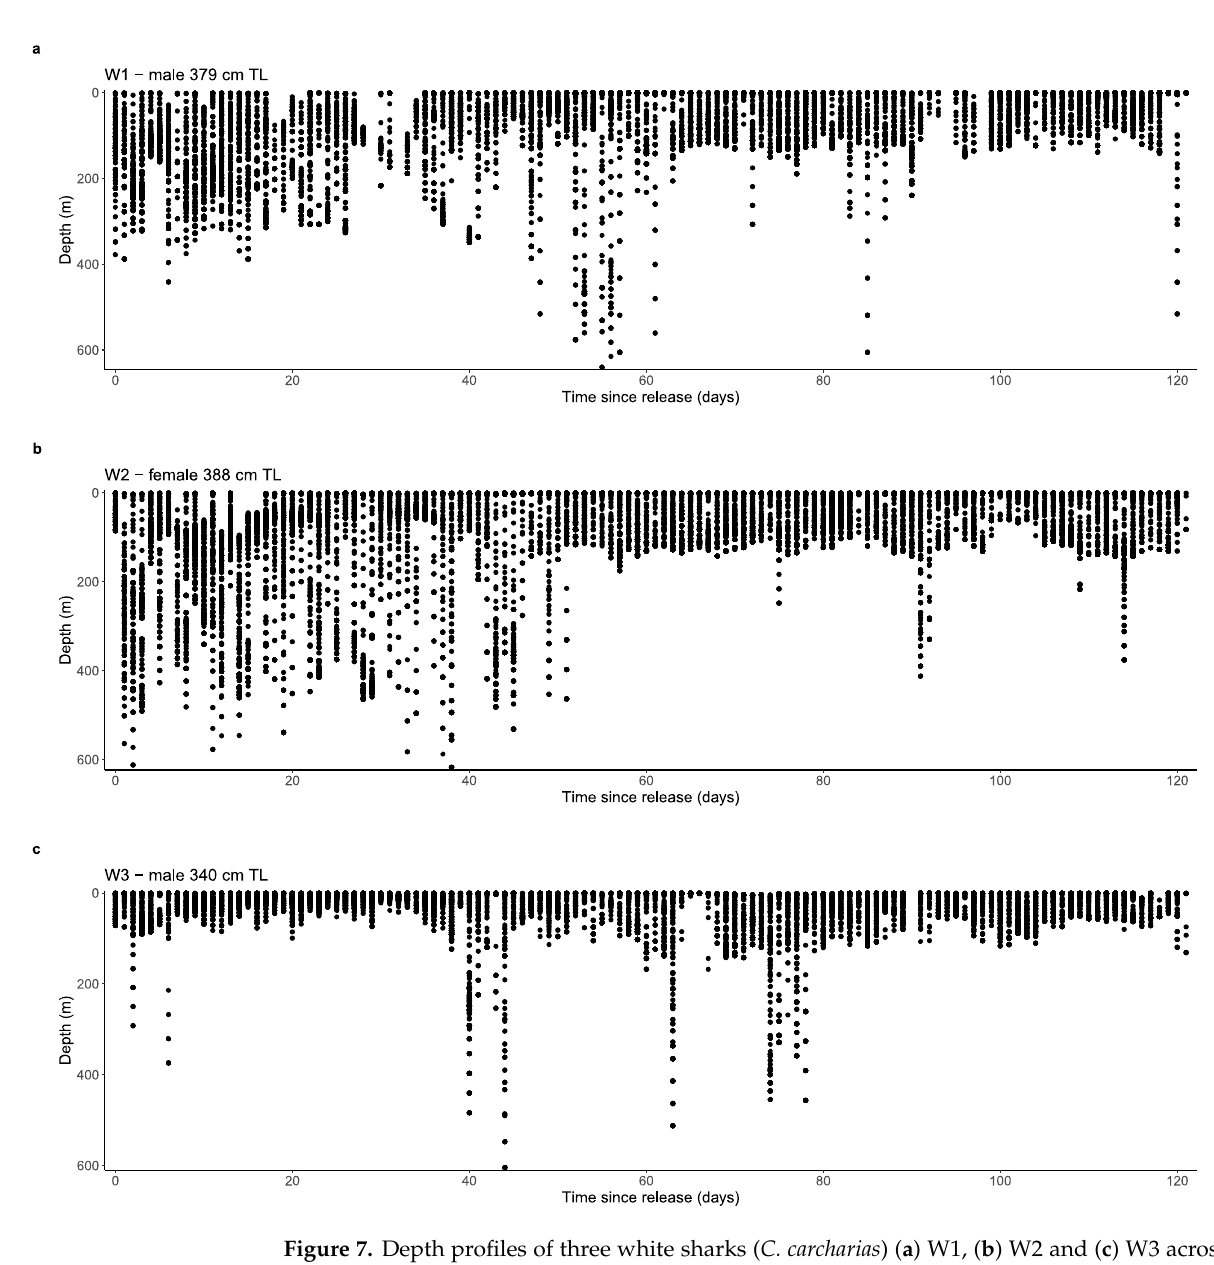
Figure 7. Depth profiles of three white sharks ( C. carcharias ) ( a ) W1, ( b ) W2 and ( c ) W3 across the 120 d MiniPAT tag deployment.